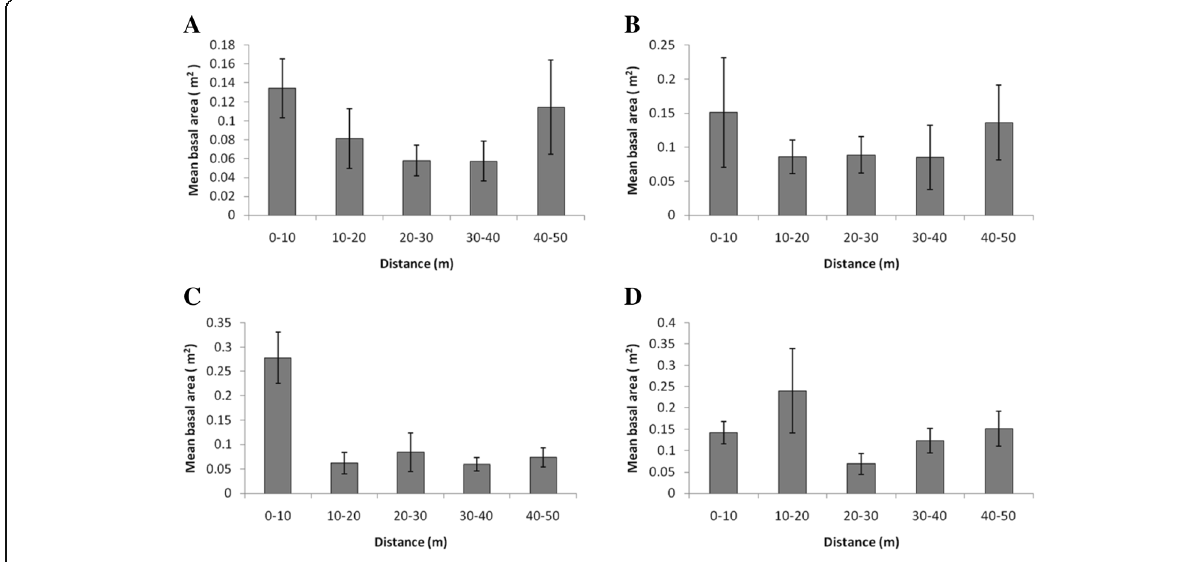
Fig. 2 Mean basal area variation with distance from surface water in Boro ( a ), Seronga ( b ), Jao ( c ), and UPH ( d )